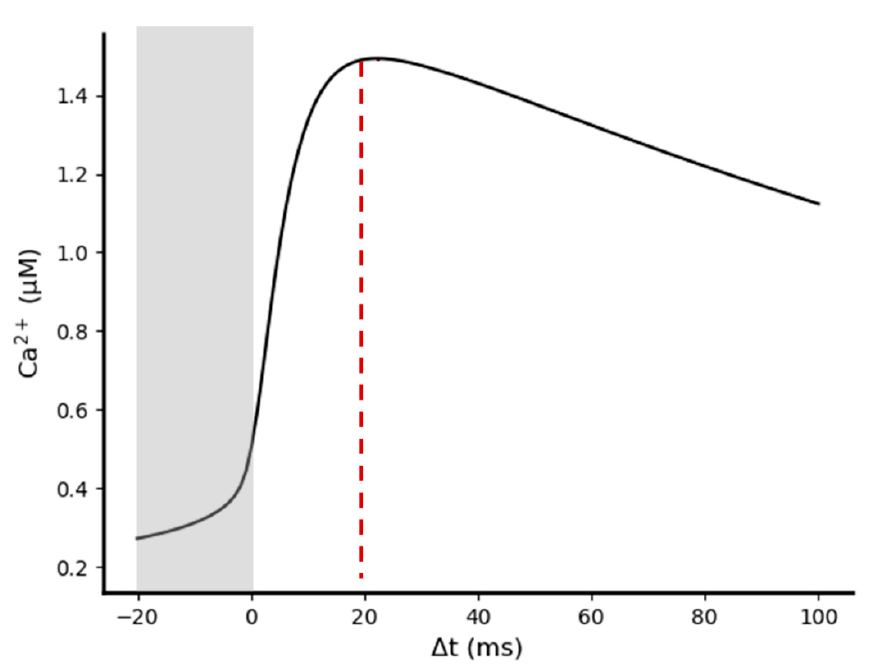
Figure 8. Relationship between pre/post-synaptic stimulation timing and the Ca 2+ concentration peaks reached in the post-synaptic spine. Simulations were performed in the presence of 20 AMPA, 15 NMDA, and 1 mM of extracellular Mg 2+ . Maximum post-synaptic Ca 2+ concentration was reached with Δ t ≈ 20 ms. Gray rectangle highlights negative Δ t values in which post-synaptic stimuli precede pre-synaptic stimuli.